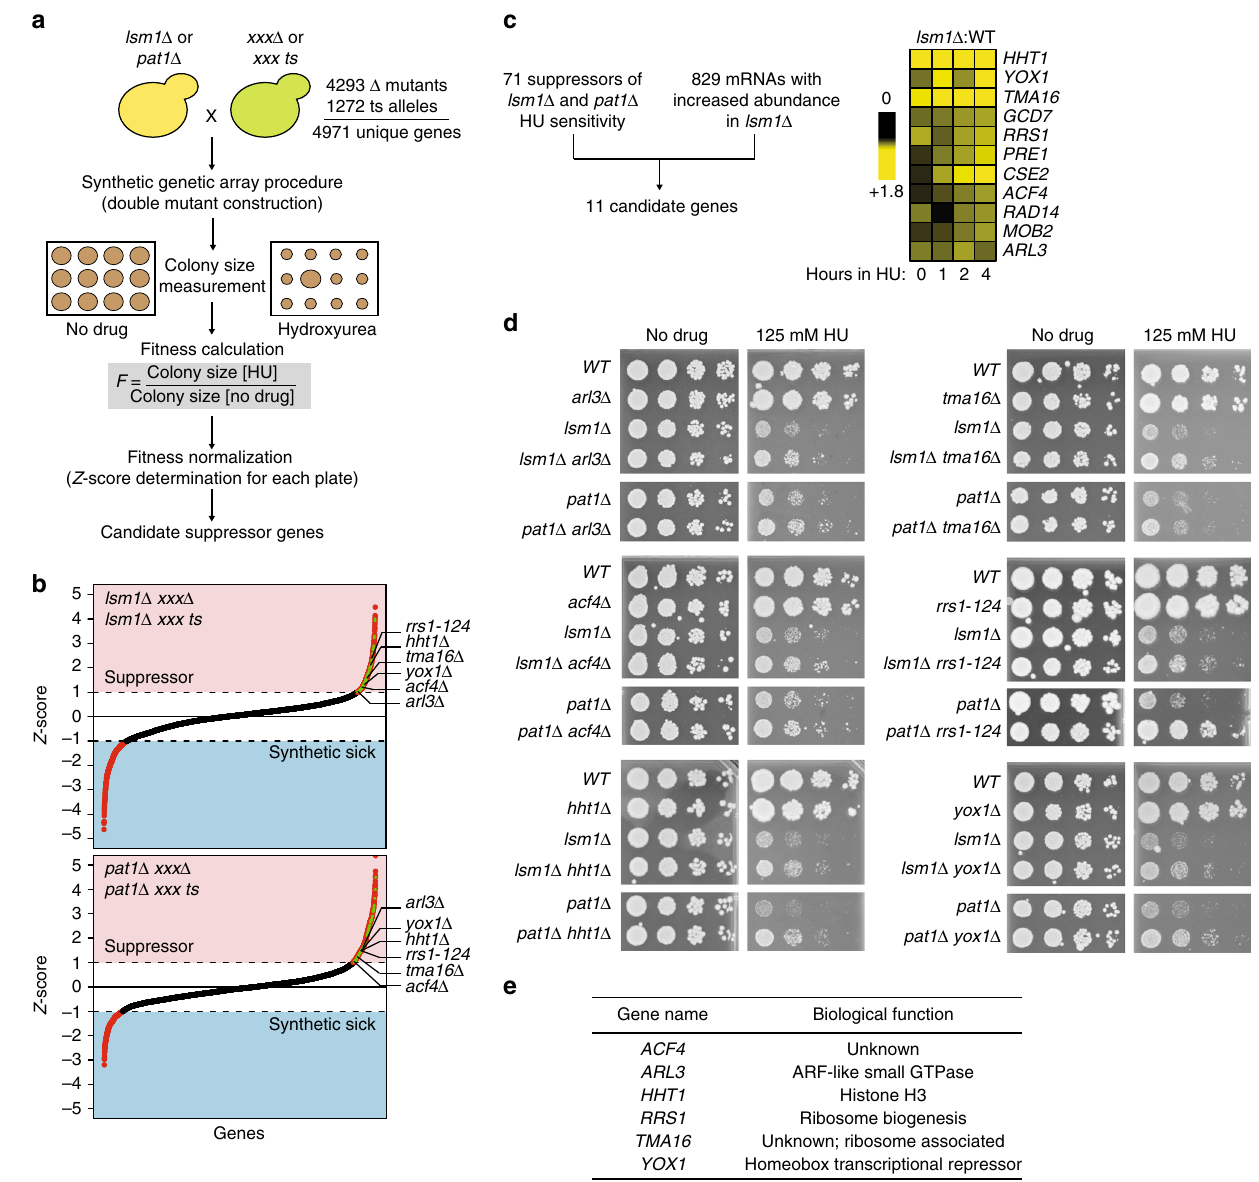
Fig. 2 Combining a systematic suppressor screen with mRNA abundance data to identify P-body targets in replication stress. a Overview of the screen to identify suppressors of the HU sensitivity of P-body mutants. b Z -score normalized HU fi tness values for the lsm1 Δ xxx and pat1 Δ xxx double mutants. Genes that were identi fi ed in both screens are indicated in green . Validated hits are indicated on the right . c The mRNA abundance during replication stress is displayed as a heatmap for eleven candidate genes from the intersection of the suppressor screen and mRNA abundance data. The log2 lsm1 Δ :WT ratio is plotted for the indicated time points. d HU sensitivity assay for the 6 validated candidate genes among the 11 genes identi fi ed in c . Ten-fold dilutions of an overnight culture were spotted on YPD medium with or without HU. e Biological functions of the validated candidate